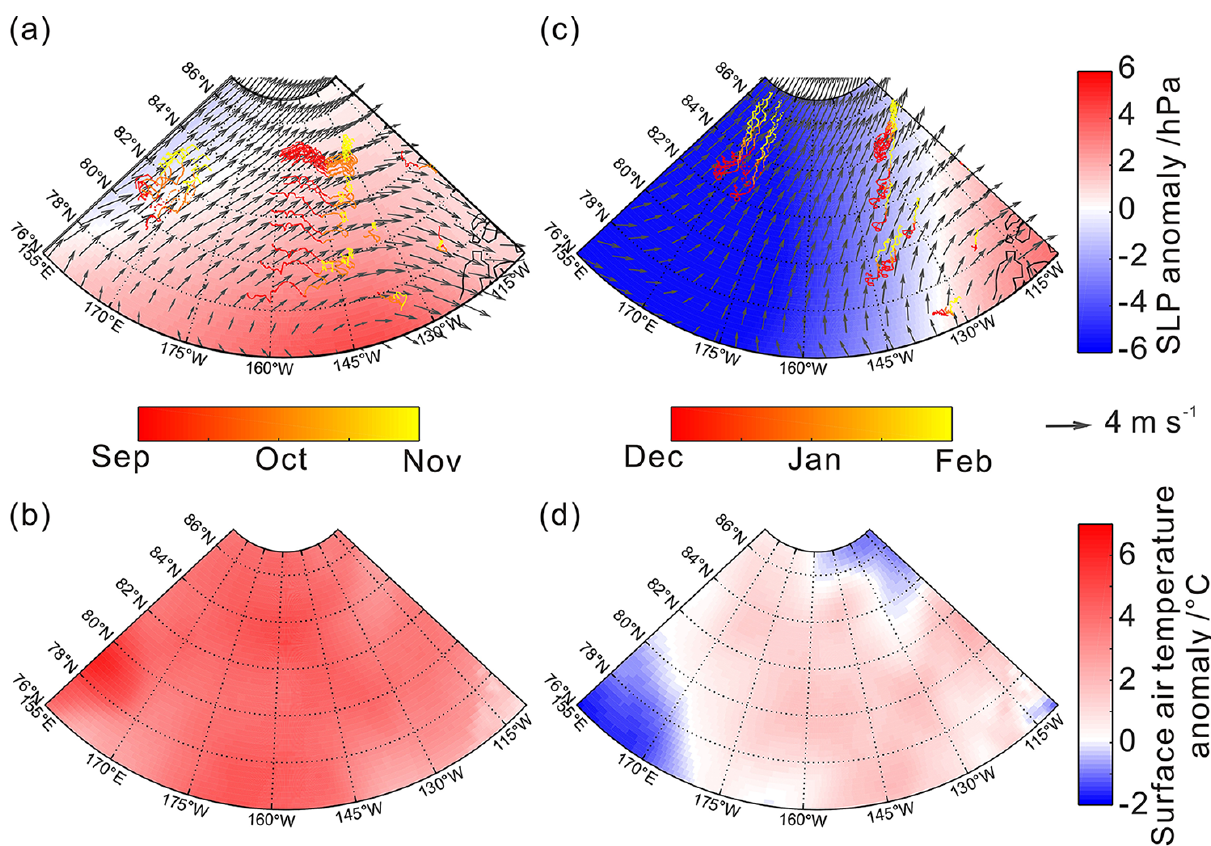
Figure 4. Anomalies of (a, c) SLP and (b, d) near-surface air temperature (2m) over the PAO during (a, b) autumn 2018 and (c, d) win- ter 2018/19 relative to 1979–2018 climatology; (a, c) arrows indicate seasonal average wind vectors, and colored lines indicate buoy trajec- tories through time. Table 1. Statistical relationships between IWSR and selected parameters. Significance levels are P < 0 . 001 (***), P < 0 . 01 (**), and P < 0 . 05 (*), and n.s. denotes insignificant at the 0.05 confidence level. Numbers in parentheses indicate number of buoys used for the statistics. Month IWSR vs. lat. IWSR vs. long. IWSR vs. W 10m IWSR vs. T 2m 20 Aug–30